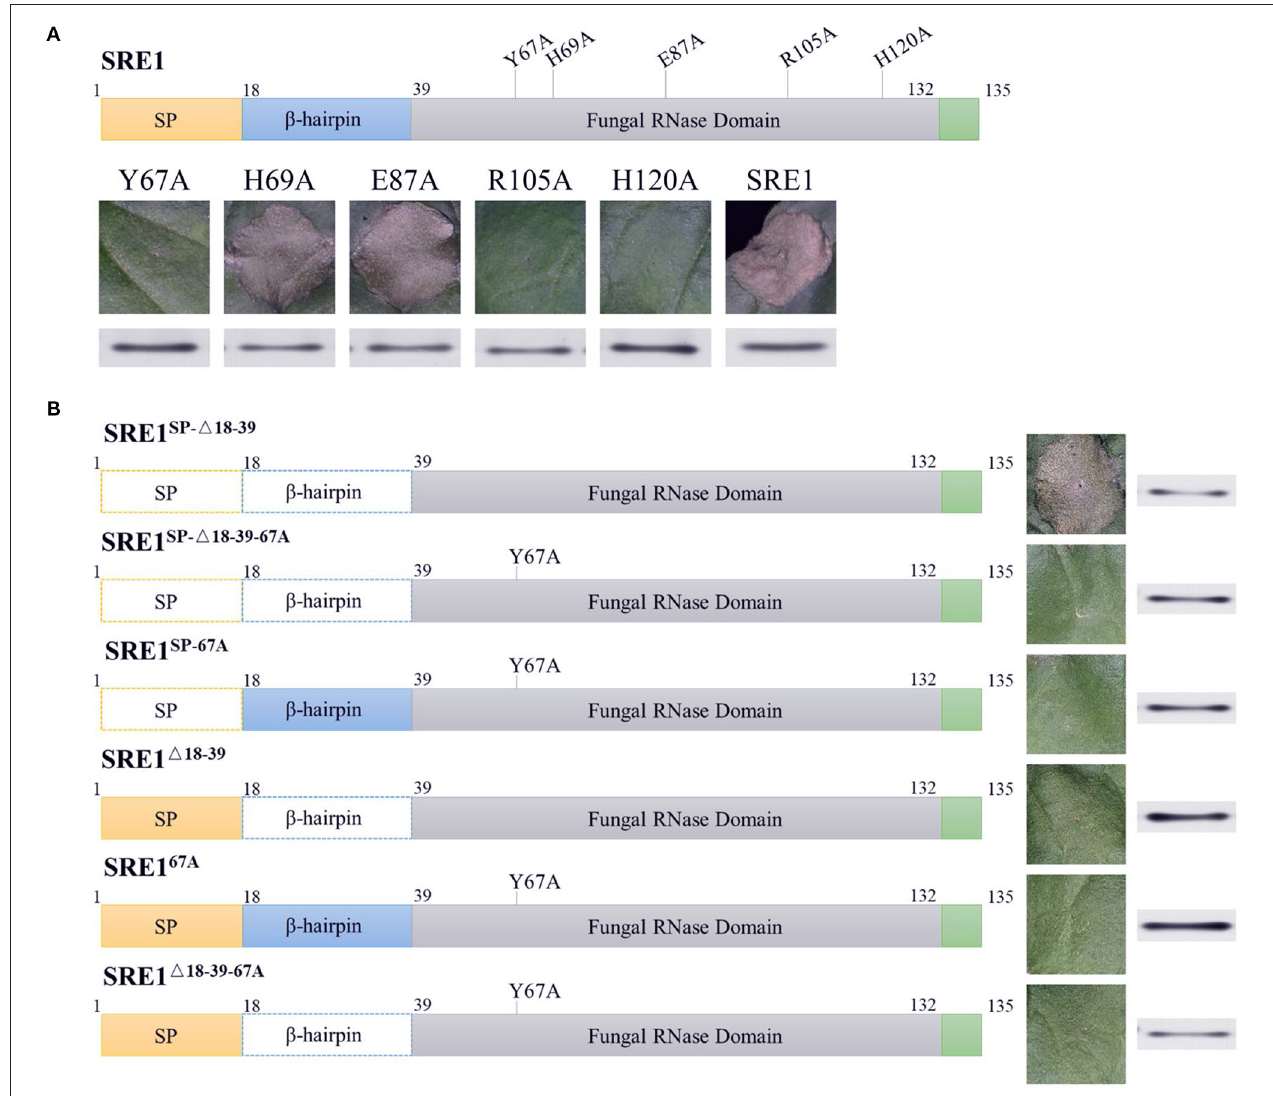
FIGURE 5 | The cytotoxicity of SRE1 depends on its enzymatic active site and N-terminal β -hairpin structure. (A) N. benthamiana leaves were infiltrated with A. tumefaciens carrying the SER1 enzyme active site mutants. Western blot analysis of 3 × HA-tagged proteins expressed in N. benthamiana leaves. (B) N. benthamiana leaves were infiltrated with A. tumefaciens carrying different mutants of the SER1. The superscripts SP, 1 18-39, and 67A, represent SRE1 missing the signal peptide, N-terminal β -hairpin, and catalytic site Y67, respectively. Western blot analysis of 3 × HA-tagged proteins expressed in N. benthamiana